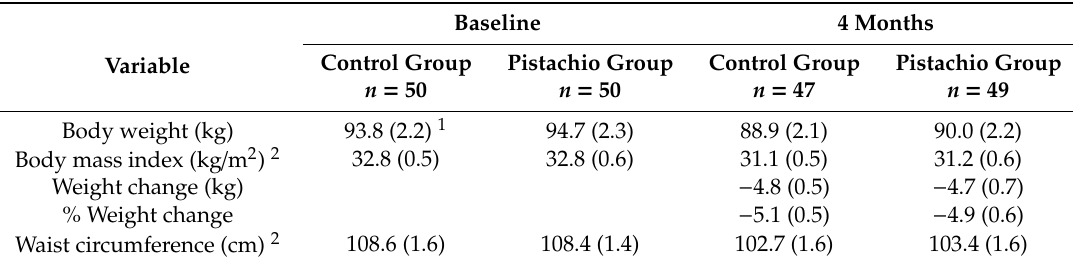
Table 2. Body measurements of study participants in the weight loss